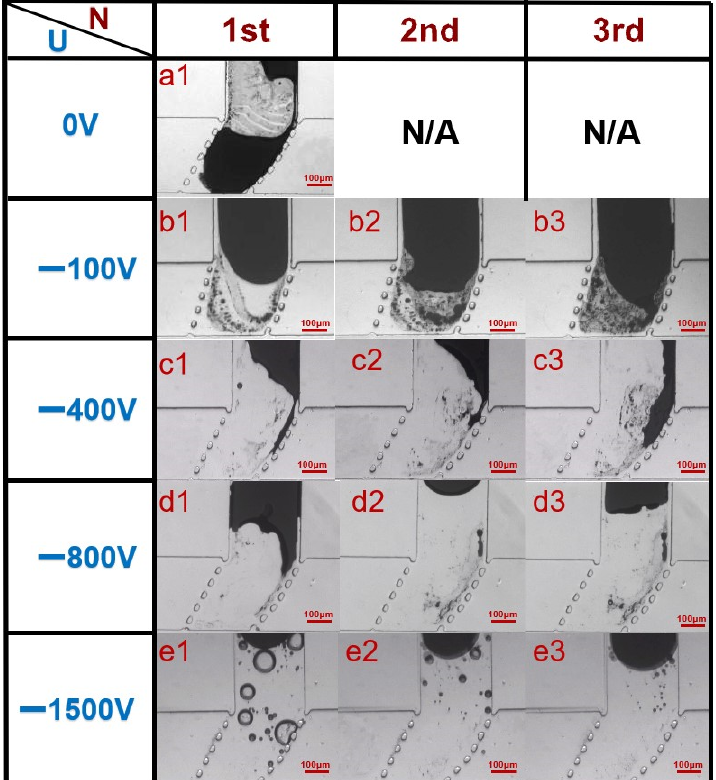
Figure 4. Diagram of the first three openings of the valve under different voltages: ( a1 ) without cathodic protection; ( b1 – b3 ) opening status of the valve the first three instances at − 100 V; ( c1 – c3 ) opening status of the valve in the fi rst three instances at − 400 V; ( d1 – d3 ) opening status of the valve in the fi rst three instances at − 800 V; ( e1 – e3 ) opening status of the valve in the first three instances at − 1500